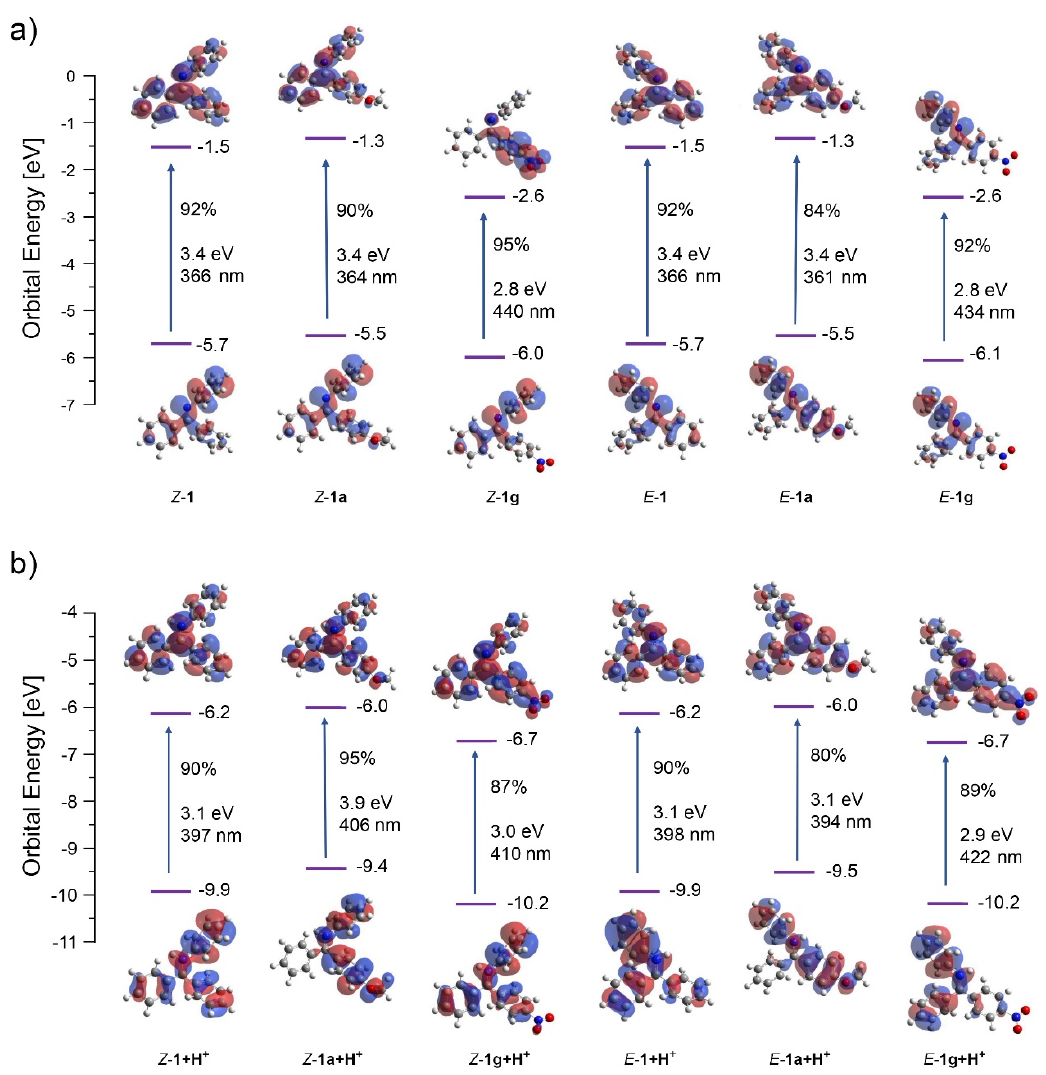
Figure 1. Orbital energies, excitation wavelengths, and dominating orbital contributions to the excited states for E and Z isomers of neutral ( a ) and protonated versions ( b ) of reactants 1 , 1a , and 1g . E and Z isomers are identical for 1 but are shown for the illustrative purposes.